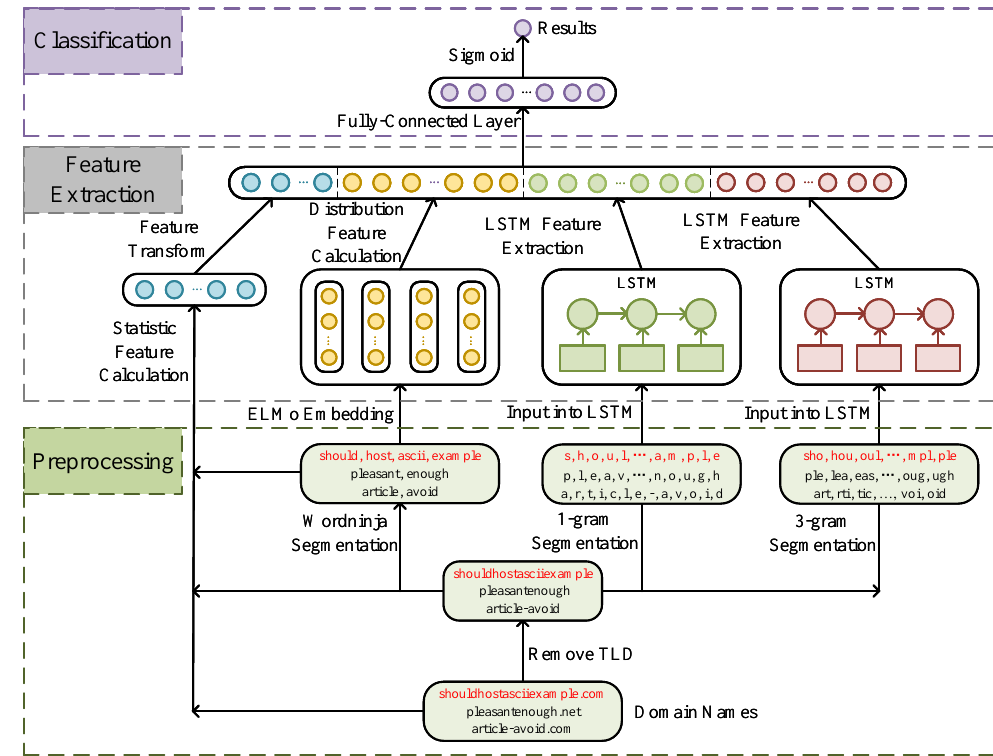
Figure 2. Structure of the AGD detection